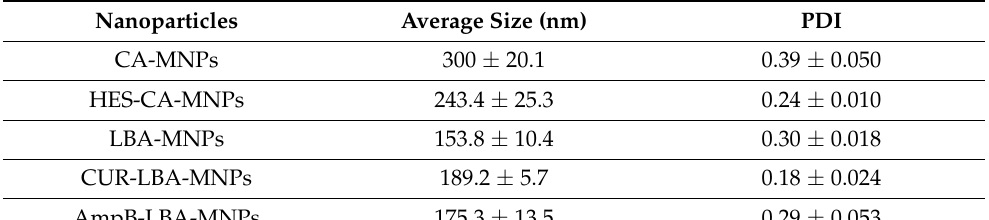
Table 2. Average size and PDI of drug-loaded CA-MNPs, LBA-MNPs, HES-CA-MNPs, CUR-LBA- MNPs, and AmpB-LBA-MNPs nanocomposites.